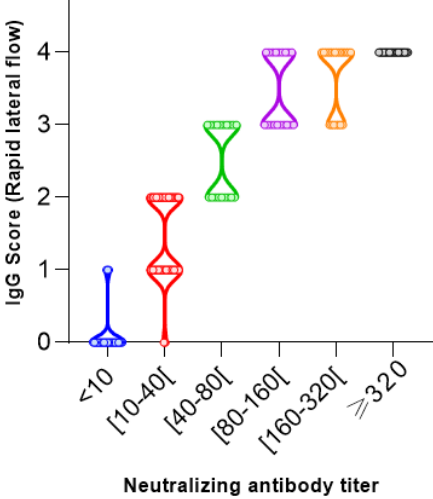
Figure 4. SARS-CoV-2 neutralizing antibody titers correlate with SARS-CoV-2 rapid lateral flow (AAZ ® ) (Spearman correlation coefficients ρ = 0.9341 and p -value < 0.0001).